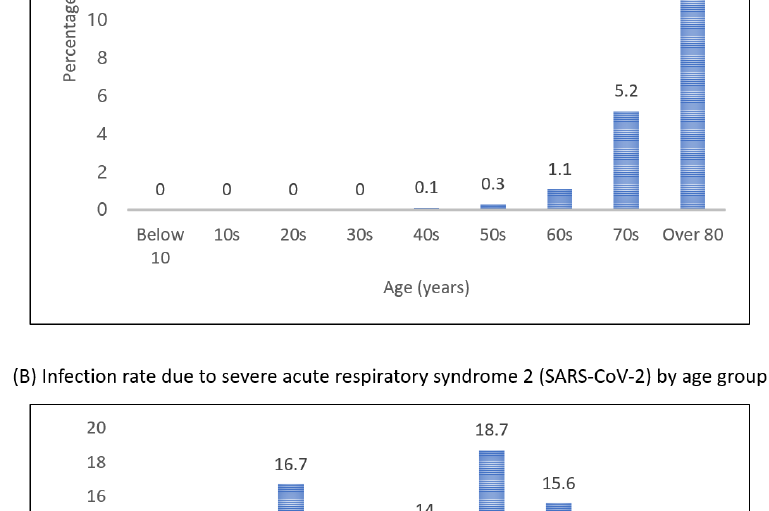
Figure 5. Change in the share of subway use hours.